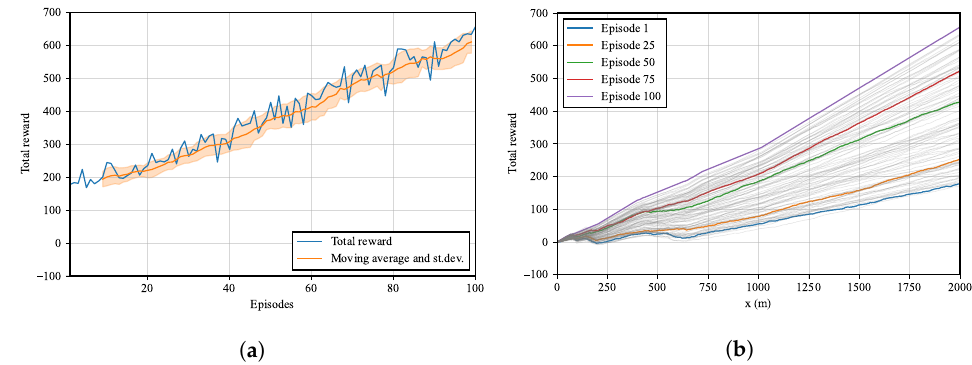
Figure 5. Rewards of the analytical environment with constant geology: ( a ) Cumulative reward vs. no. of episodes; moving average and interval of range ± one standard deviation of ten episodes (orange band). ( b ) Cumulative reward vs. excavation step for all episodes.